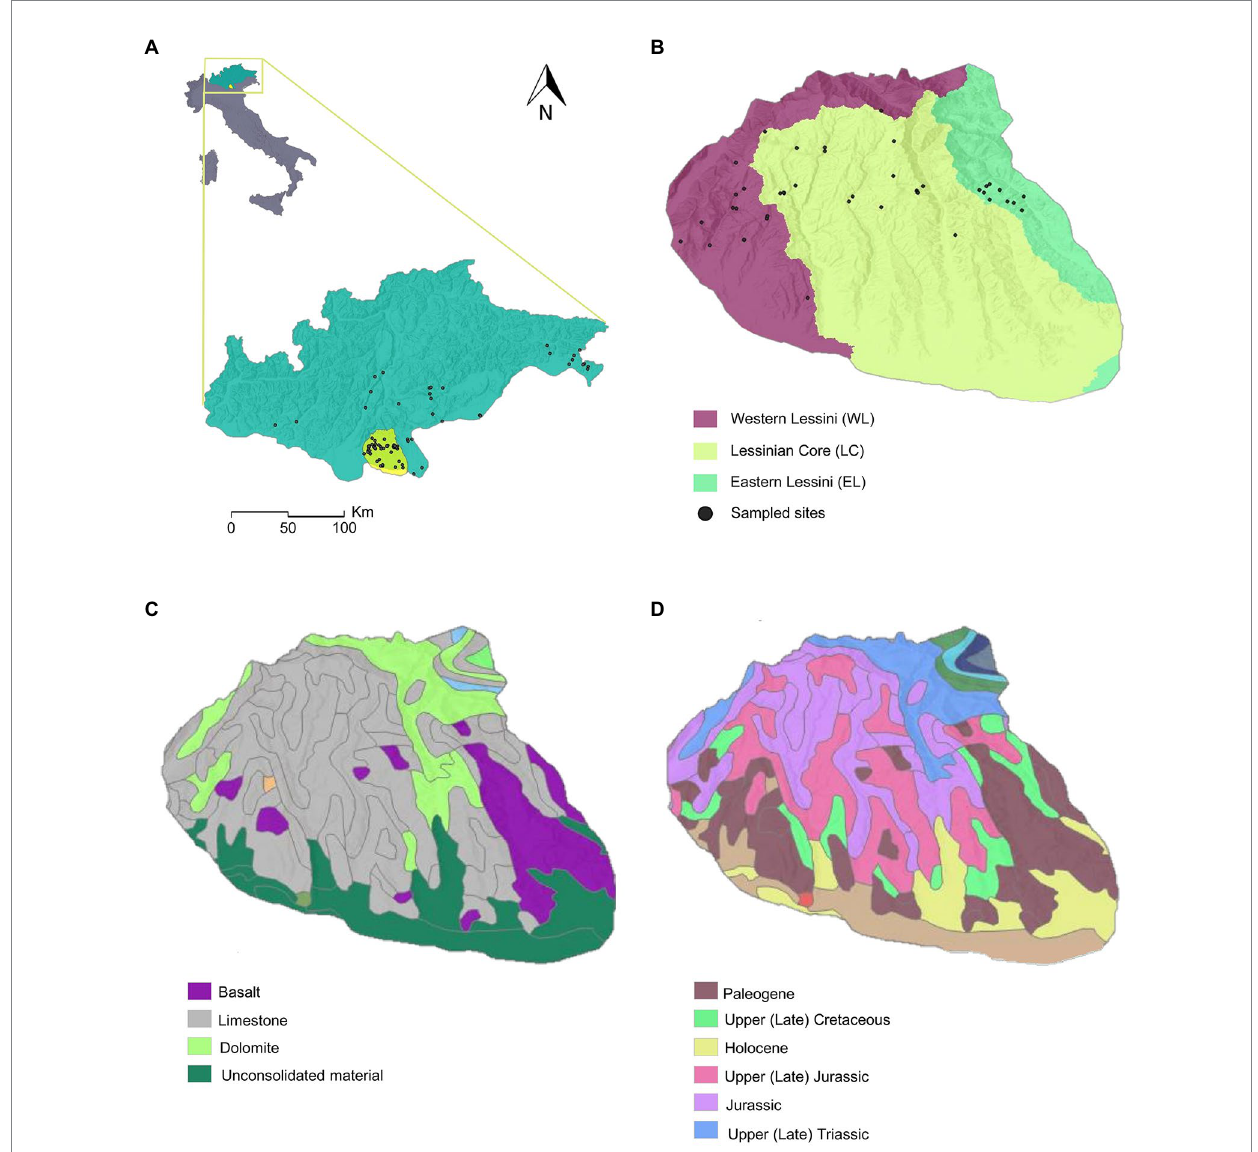
FIGURE 1 Study area and hydrogeologic maps. (A) Central-Eastern Alpine Stygoprovince, with the Lessinian Massif highlighted in yellow; (B) Lessinian Massif with the three main drainage basins as derived in ArcGIS Pro 2.8; (C) map of the main lithologies; (D) map of the lithological ages. In (A) and (B) sampled sites are represented by black